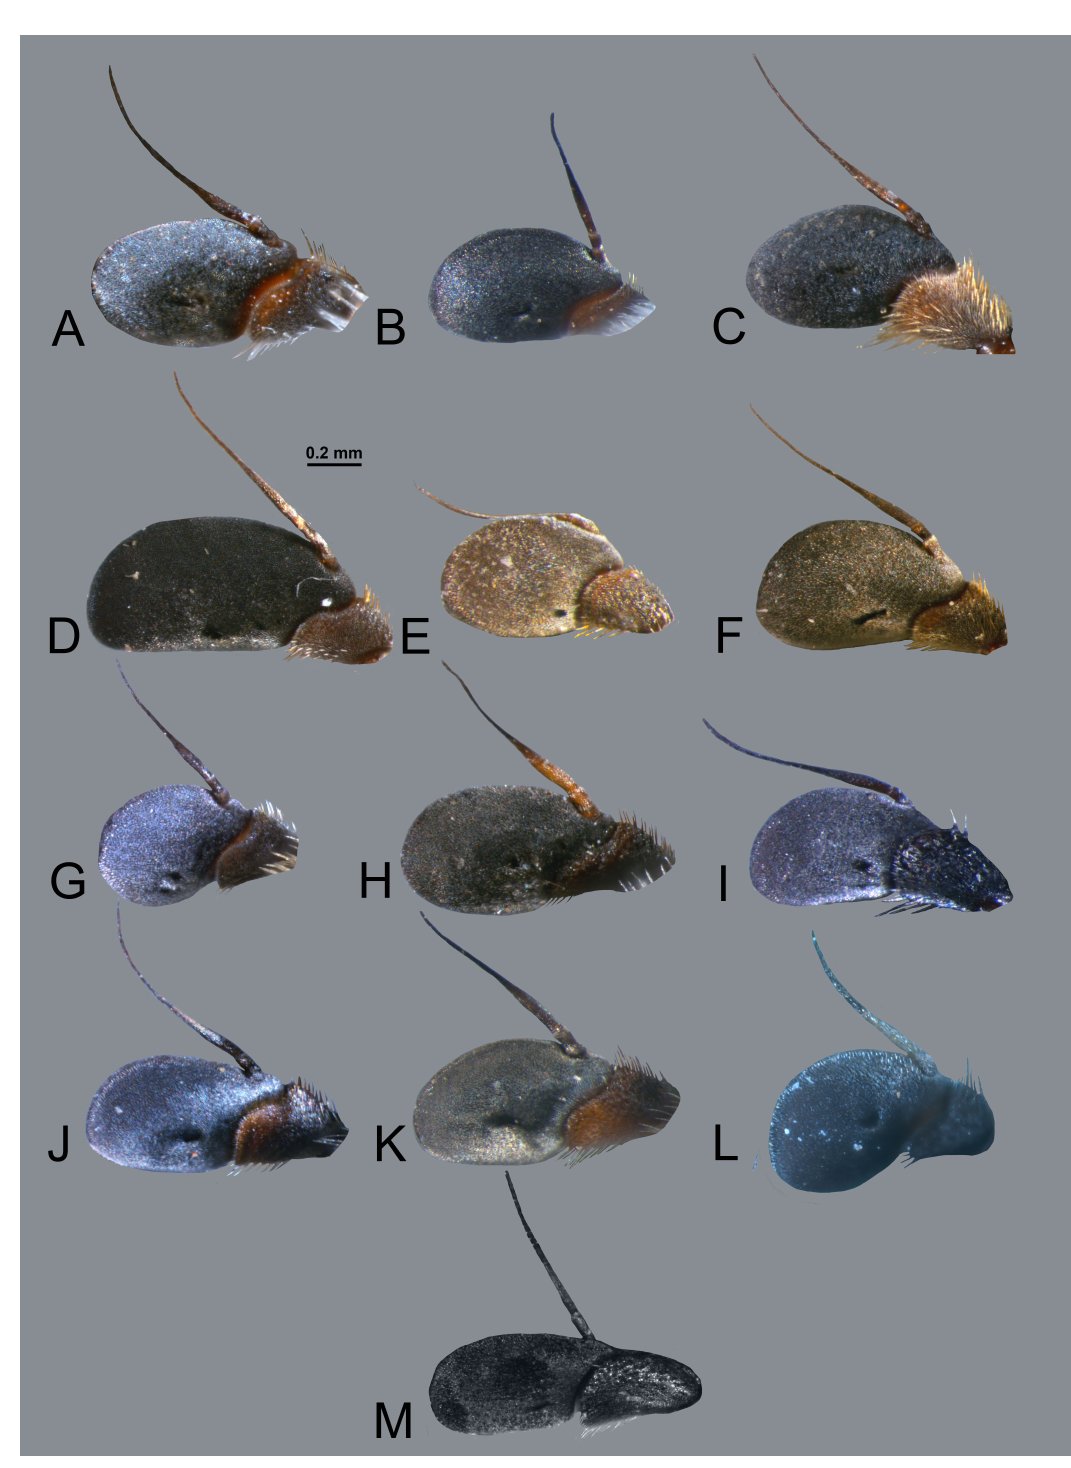
Fig. 3. Megatrigon spp., left antenna, lateral view. A . Megatrigon argenteus (Walker, 1852) comb. nov. (♂). B . M. argentifrons sp. nov. (♂) . C . M. argentimaculatus sp. nov. (♂). D . M. magnicornis sp. nov. (♂). E . M. natalensis sp. nov. (♂). F . M. sexmaculatus sp. nov. (♂). G . M. apiformis sp. nov. (♂). H . M. cooksoni sp. nov. (♂). I . M. immaculatus sp. nov. (♂). J . M. ochreatus (Hull, 1964) comb. nov. (♂). K . M. tabanoides sp. nov. (♂). L . M. jacobi (Hervé-Bazin, 1913) comb. nov. (♂). M . M. nivalis (Hull, 1964) comb. nov. (♀)